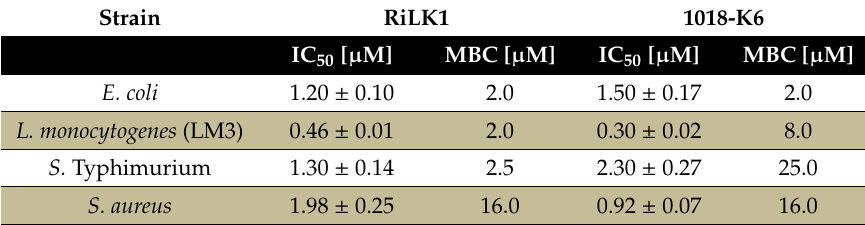
Figure 5. Dose-response e ff ect of RiLK1 on the survival of di ff erent foodborne pathogens. Bacteria were incubated in the presence of increasing concentrations of the peptide. Data were determined by enumeration of the surviving colony forming units (CFU) on plates seeded with the pathogen incubated with the di ff erent peptide concentrations. Results were expressed as the percentage of colony forming units (CFU) survival, with respect to the colony counted in the control plates. The half-maximal inhibitory concentrations (IC 50 ) and Minimal Bactericidal Concentration (MBC) values of the tested peptide against each bacterial strain were calculated using GraphPad Prism version 6.00. Data are presented as means ± standard deviation (s.d.) of three separate experiments performed in triplicate.